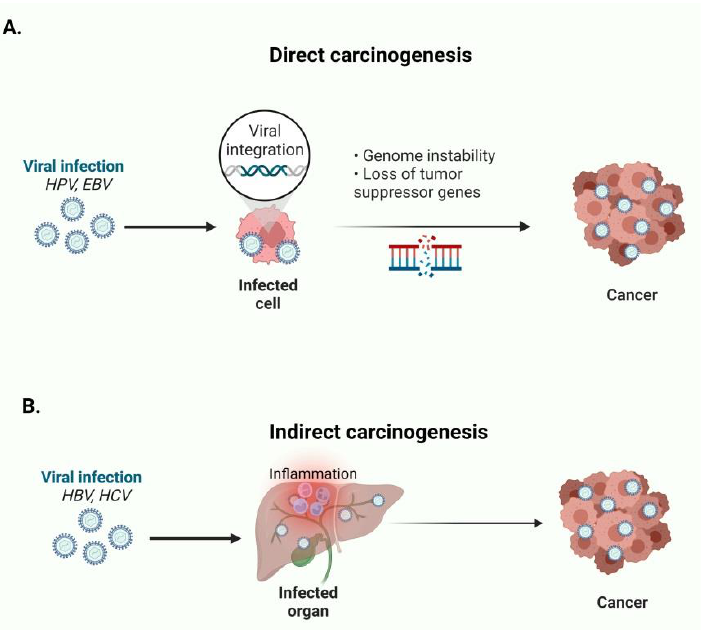
Figure 1. ( A ) HPV and EBV directly cause oncogenesis by expressing oncogenic proteins and estab- lish genome instability. ( B ) HBV and HCV indirectly cause carcinogenesis by establishing chronic inflammation of the infected organs. This figure was created based on the tools provided by Bioren- der.com (accessed on 9 March 2022).